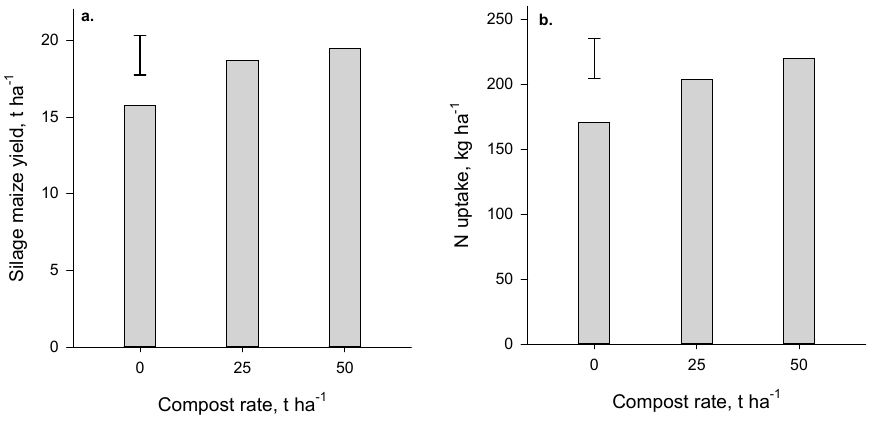
Figure 4. Effect of compost application rate on ( a ) dry matter yield and ( b ) N uptake by maize (the first crop grown in the Arable trial after compost application). Bars represent 5% LSD with 6 df .